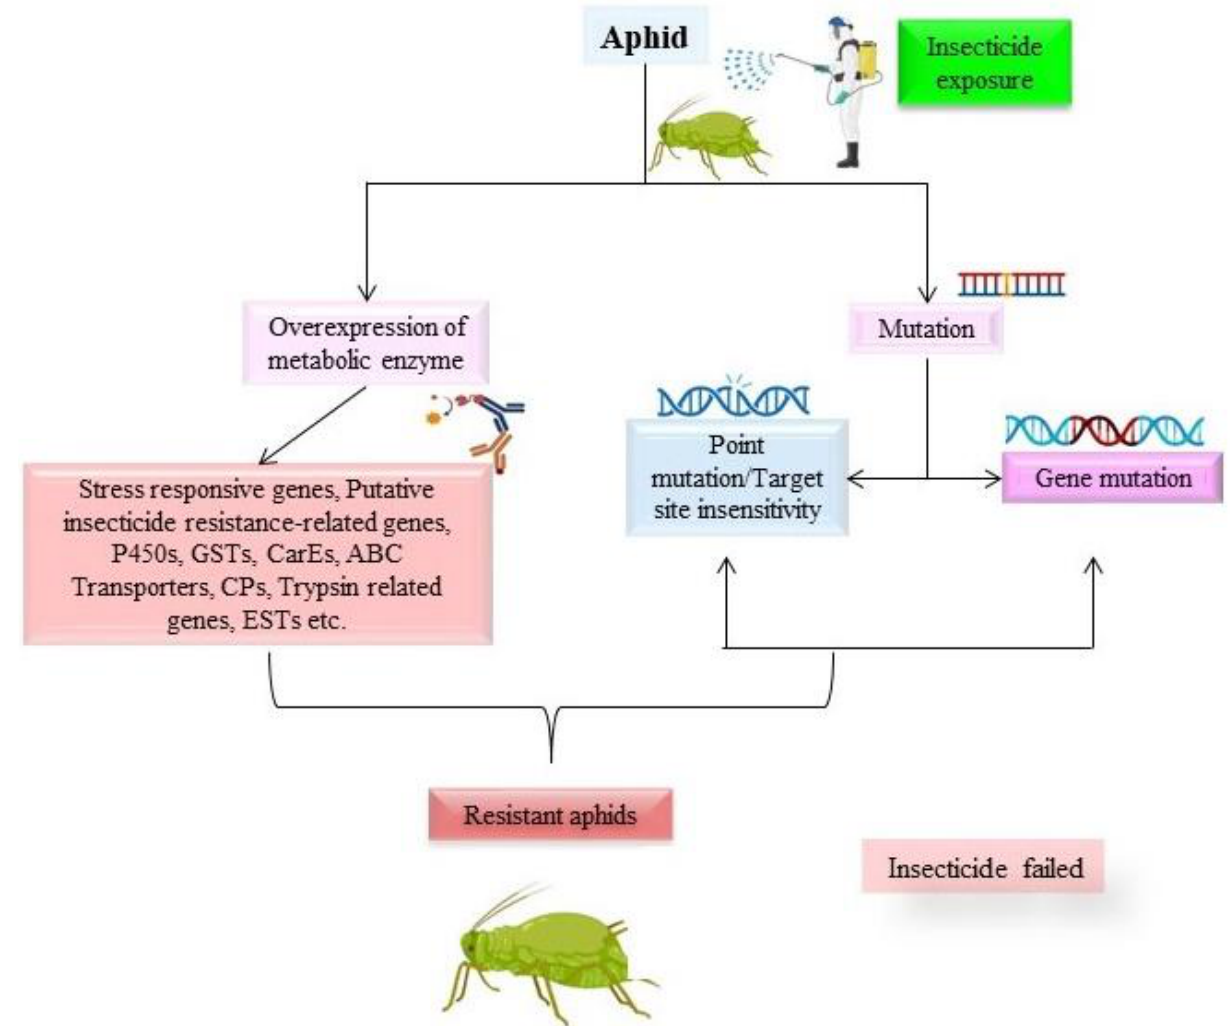
Figure 1. Illustration of the effects of insecticide exposure on aphids. The figure demonstrates how the insecticide fails and resistant aphids are